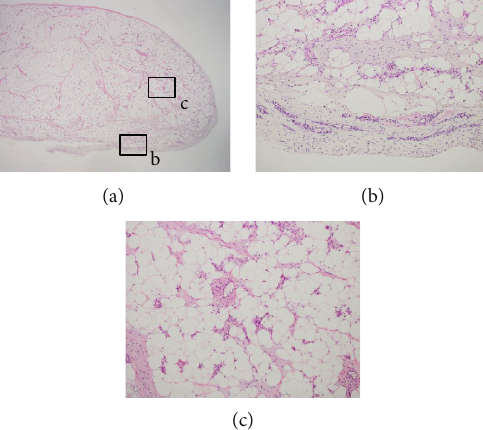
Figure 4: Histopathological fi ndings of the tumor Photomicrographs (original magni fi cation, HE stain) (a, × 40; b and c, × 400) reveal that the tumor comprises mature adipocytes covered with a fi brovascular capsule, peripherally. Blood vessels and fi brous components are observed in the septum. The blood vessels are small-caliber capillaries. No fi ndings consistent with malignancy were